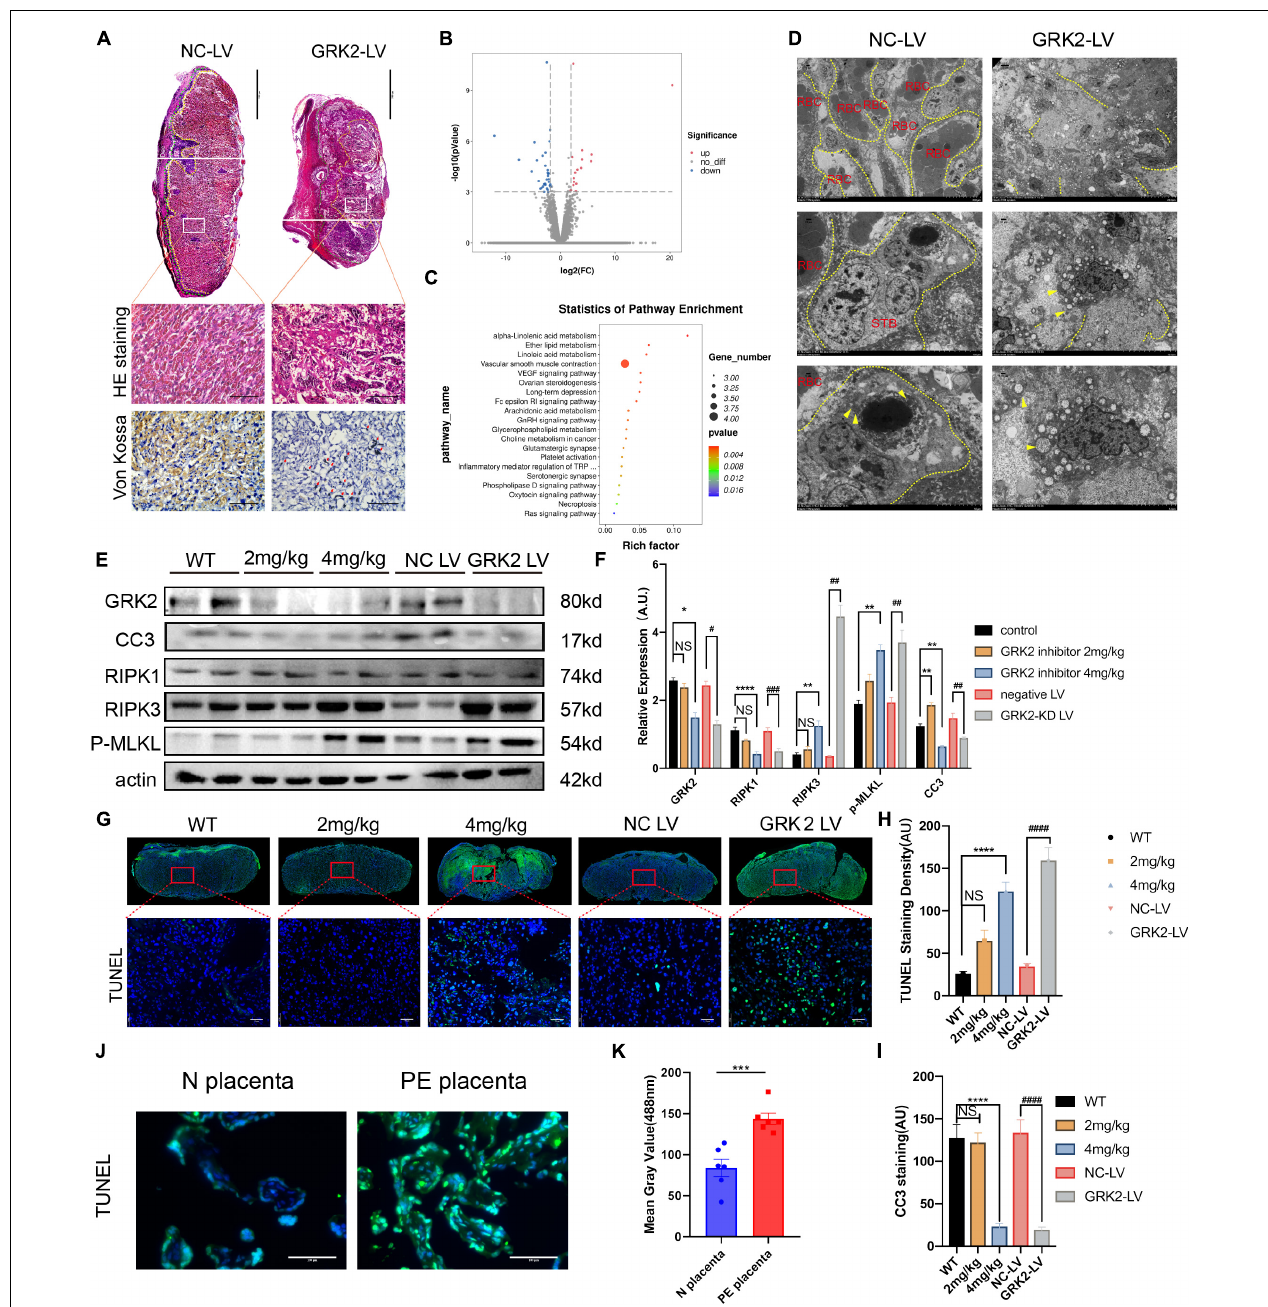
FIGURE 3 | Suppression of GRK2 in placenta compromises placentation via necroptosis. (A) The 1st panel: Representative H&E staining images of E18.5 placentae from NC-LV and GRK2-LV groups. GRK2-LV placentae display a lack of vascularization, smaller placental size and a smaller labyrinth. Scale bar, 500 µ m. Yellow lines, labyrinth and junction zone boundary; Green lines, junction zone and decidua boundary. The 2nd panel: Higher magnification of the upper white rectangle. Scale bar, 100 µ m. 2nd and 3rd panels: The H&E staining and Von Kossa staining illustrate placental infarction and calcium deposition (red arrows) in GRK2-knockdown mice, respectively. (B) Volcano plots show differential expression for comparisons between GRK2-LV and NC-LV placentae ( N = 3 per group. (C) Kyoto Encyclopedia of Genes and Genomes (KEGG) pathway analysis for the differentially expressed genes in total RNA-seq: GRK2-LV vs. NC-LV groups ( N = 3 per group). (D) TEM images show extensive necrosis in labyrinth layer of GRK2-LV group. Yellow dotted line, cell membranes; Yellow arrows swelling mitochondria. From upper to bottom, 500 × , 1,500 × , 2,500 × magnification, respectively. (E,F) Western blot analysis of placental cleaved-caspase 3, RIPK1, RIPK 3, phospho-MLKL (p-MLKL; S358), and β -actin (loading control). The DNA fragment analysis (G,H) and apoptosis rate analysis (I) in mice term placentae. Green signal indicates TUNEL-positive nuclei. Scale bar, 50 µ m. (J,K) The DNA fragment in patients’ placentae. Scale bar, 100 µ m. Dec, decidua; JZ, Junction Zone; Lab, labyrinth; H&E, hematoxylin and eosin staining; RBC, red blood cells; STB, syncytiotrophoblast. Data present as X ± SEM; NS, not significant; * P < 0.05, ** P < 0.01, *** P < 0.001, **** P < 0.0001 versus WT group; # P < 0.05, ## P < 0.01, ### P < 0.001, #### P < 0.0001 versus NC-LV group.